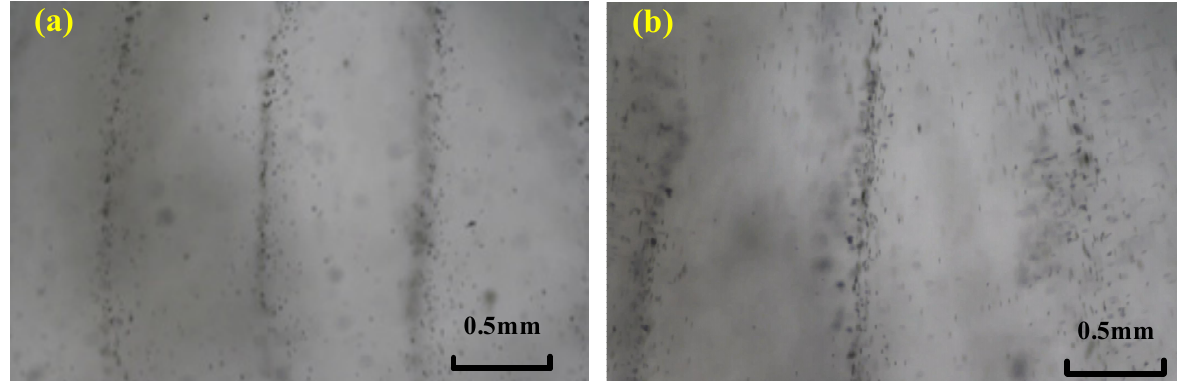
Figure 8. Particle pattern actuated by ( a ) the IEM mode and ( b ) the AEM mode with a driving frequency of 1 MHz.